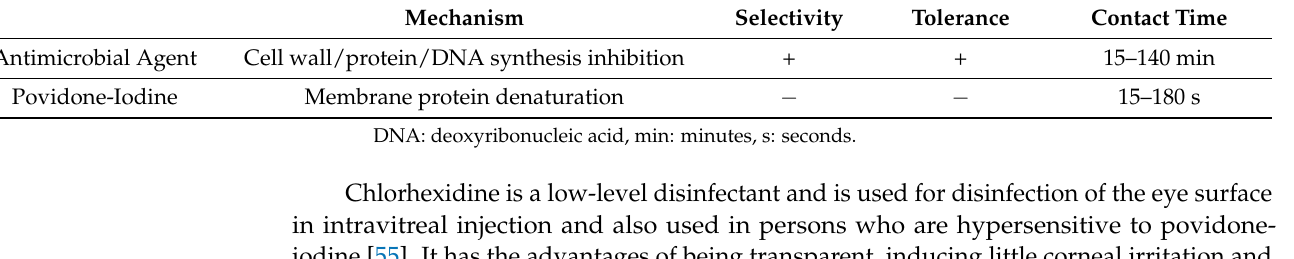
Table 1. Antimicrobial characteristics of antimicrobial agents and povidone-iodine. Antimicrobial Mechanism